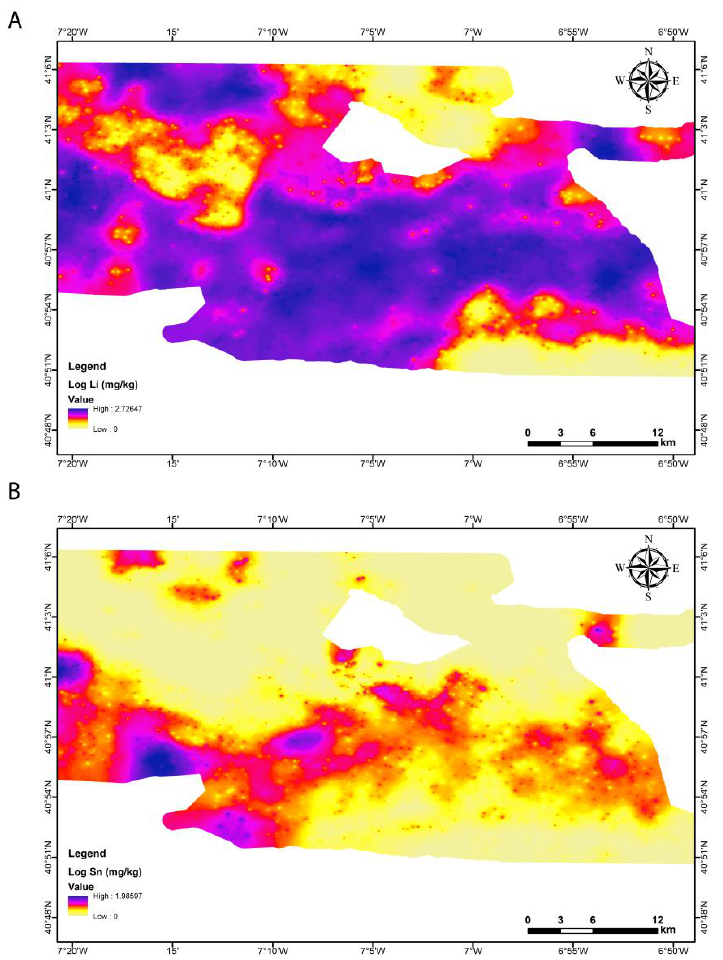
Figure A1. Geochemical anomaly maps for Li ( a ) and Sn ( b ) before excluding the granitic areas.